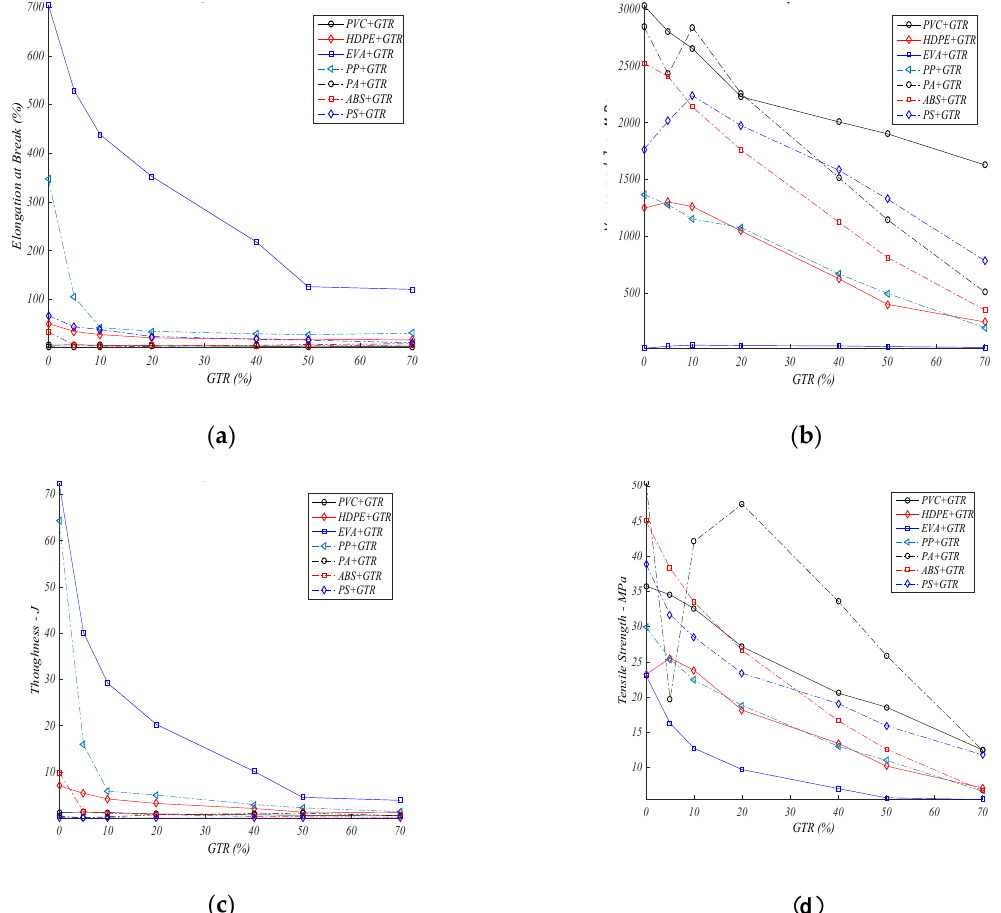
Figure 11. Mechanical properties analysis: ( a ) elongation at break (%), ( b ) Young ’s modulus (MPa), ( c ) toughness (J), ( d ) tensile-strength (MPa), for several polymers and GTR amounts (particle diameter lower than 200 μm) .